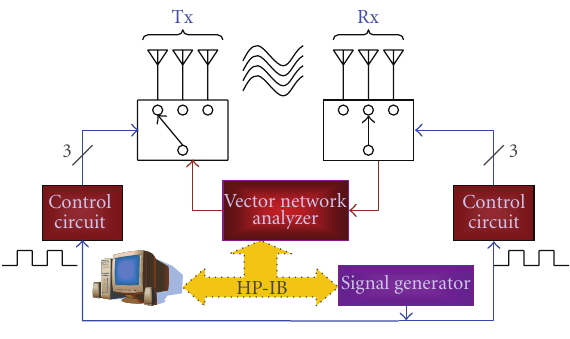
Figure 1: MIMO measurement system. Table 1: Parameters of